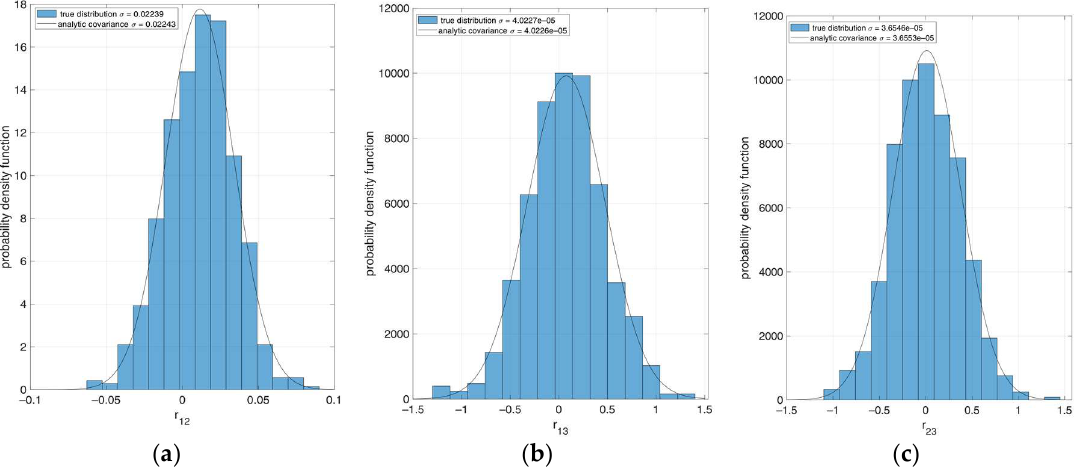
Figure 1. Comparison between the numerically retrieved error distributions and analytic variances for three off-diagonal elements of the attitude matrix. ( a ) r 1,2 ; ( b ) r 1,3 ; and ( c ) r 2,3 .